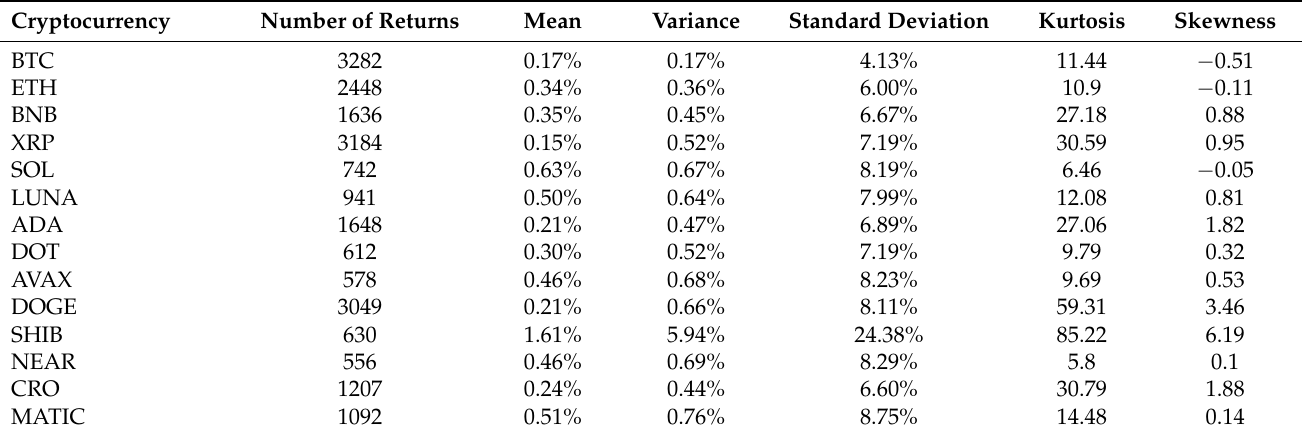
Table 3. Risk characteristics of the 14 return